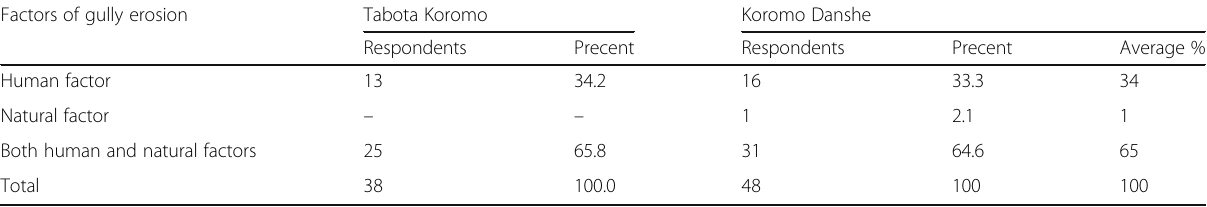
Table 2 Perceptions of HHR on the drivers of gully erosion Factors of gully